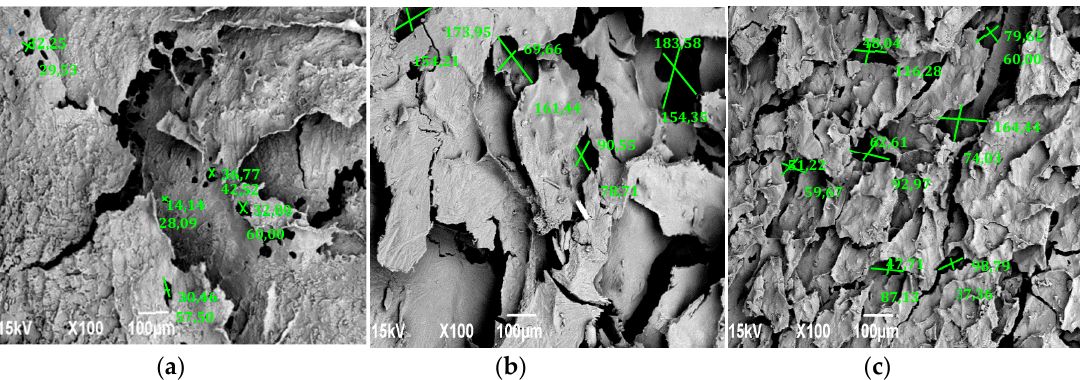
Figure 6. Scanning electron microscopy of chitosan (CS) scaffolds ( a ) without graphene oxide (GO), ( b ) with 0.5% GO and ( c ) with 1.0% GO.